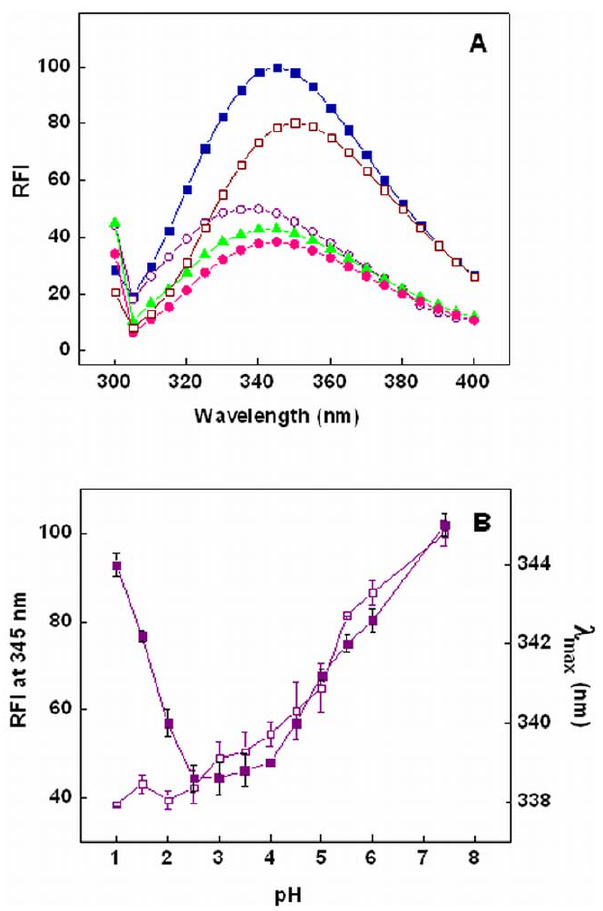
Figure 4. pH dependence of Trp fluorescence of chymopapain. N (A) Fluorescence emission spectra of chymopapain at pH 7.4 (- & -), -) and in the presence of 6M pH 3.0 (- # -), pH 1.5 (- m -), pH 1.0 (- GuHCl (- % -). (B) Changes in relative fluorescence intensity (RFI) at 345 nm (- % -) and emission maxima (- & -) of chymopapain as a function of pH. Spectra were obtained by exciting Trp at 295 nm. Protein concentration was 8 m M.